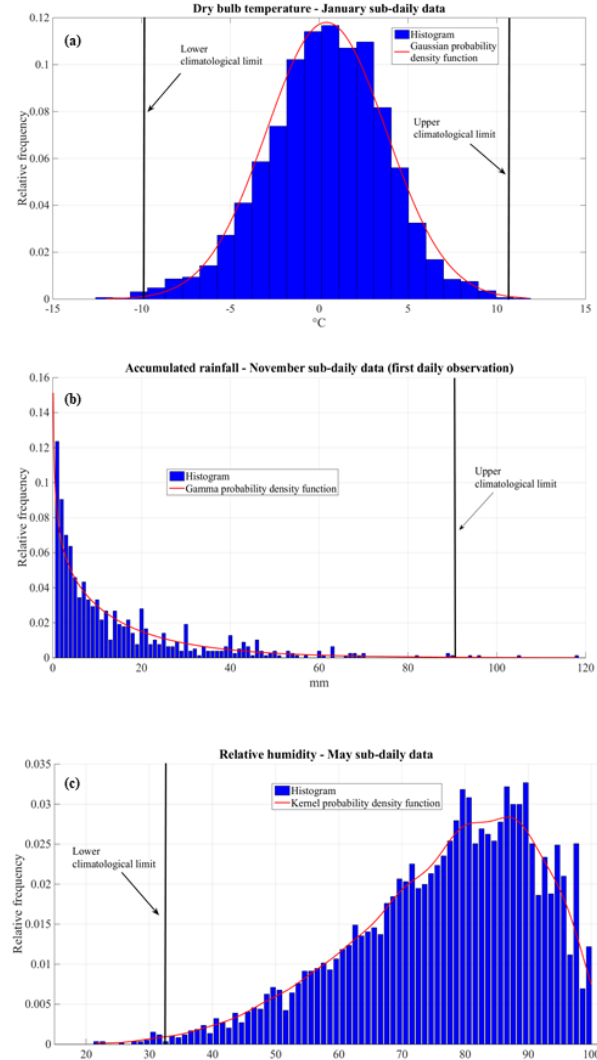
Figure 6. Examples of probability distribution models designed within the framework of the tolerance test. Panel (a) shows the Gaussian probability density function applied to dry-bulb temper- ature collected in January, panel (b) the gamma distribution den- sity function used to model accumulated rainfall data measured in November and panel (c) the kernel density function applied to rela- tive humidity records collected in May. Vertical black lines indicate the tolerance limits fixed using the criteria expressed from Eqs. (5), (6), (7) and